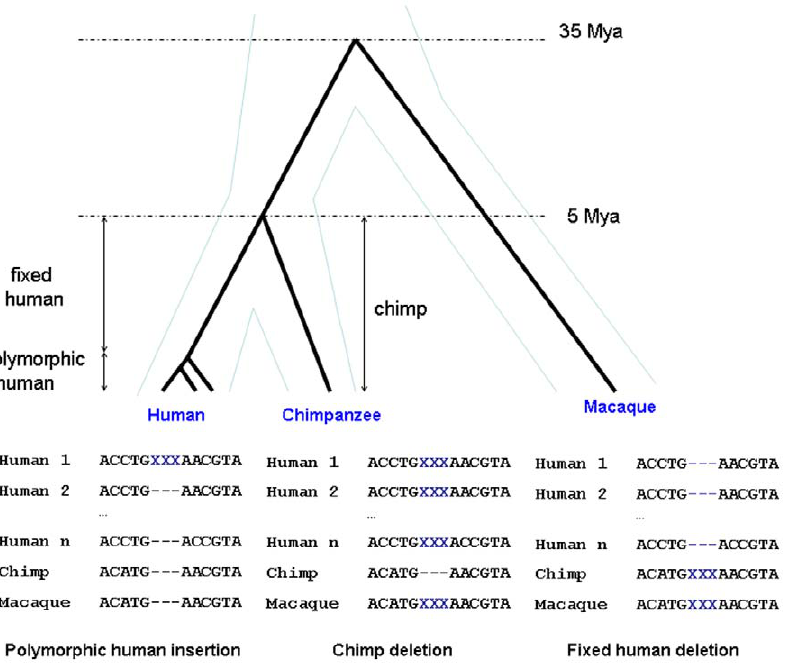
Figure 1. Examples of orientation of indels and definition of data. Dating is approximate and drawing is not to scale. Thin blue lines denote species boundaries and thick black lines denote the gene genealogy underlying the sequence data used in that study.